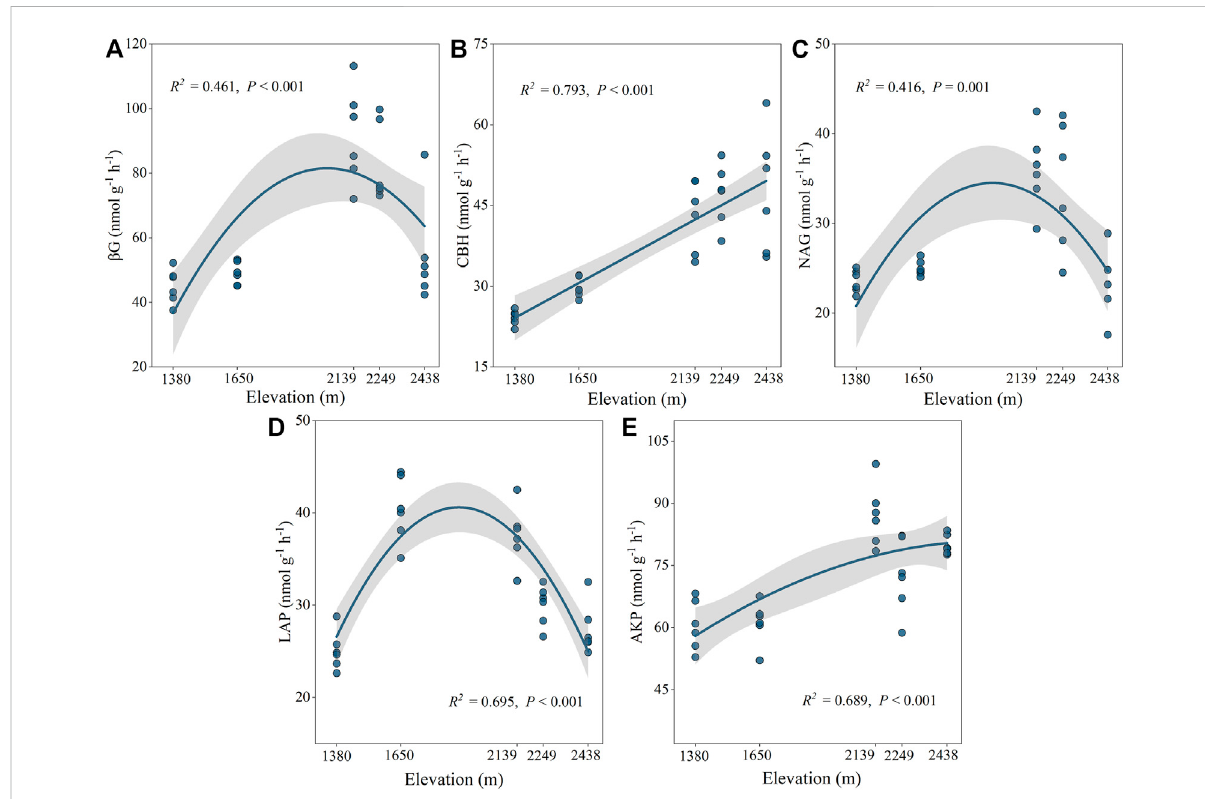
FIGURE 2 Ecoenzymatic activities at different altitudes. BG: β -1,4-glucosidase (A) , CBH: Cellobiohydrolase (B) , NAG: β -1,4-N-acetylglucosaminidase (C) , LAP: leucine aminopeptidase (D) , AKP: alkaline phosphatase (E) .